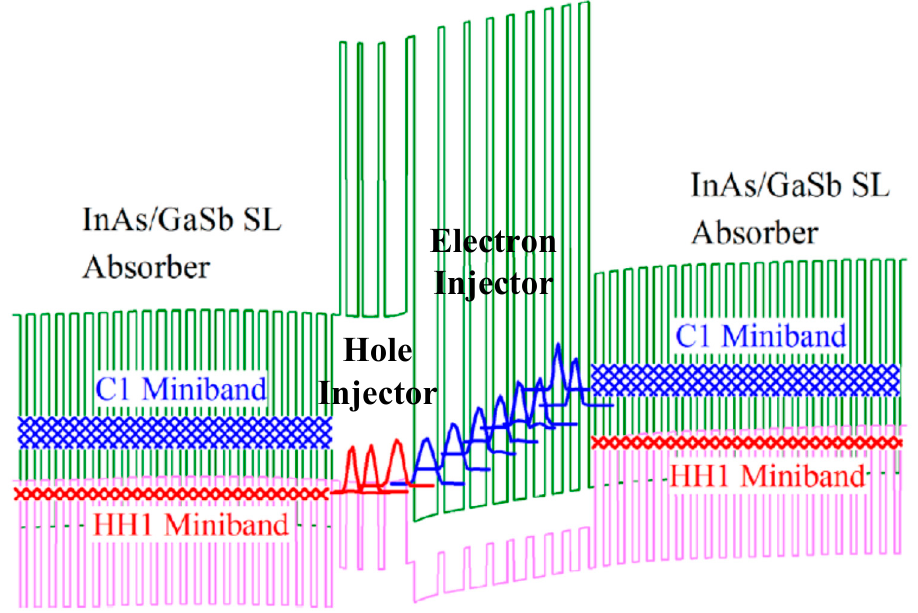
Figure 21. Schematic of the band profiles and wavefunctions for 1½ periods of an interband cascade detector structure at a small reverse bias. In this example, the absorber region of each stage is an InAs/GaSb type-II superlattice. Reproduced from Ref. [199], with the permission of AIP Publishing.